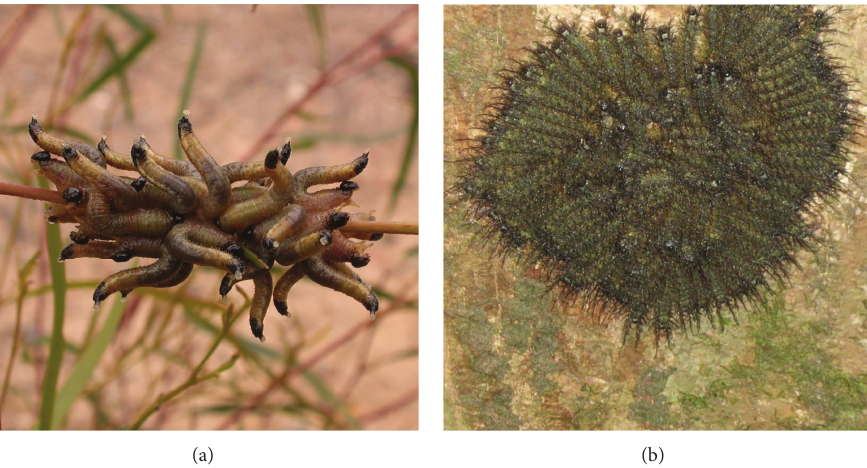
Figure 3: (a) Larvae of Perga sp. (Pergidae) rest aggregated in a cycloalexic formation. Even around a stem of their host plant, Eucalyptus sp., spitfire larvae rest with their heads outwards, Black Mountain, Canberra, ACT, Australia. Photograph by Donald Hobern on 24 May 2010 (CC BY 2.0). (b) Probable cycloalexy with heads pointing outwards in caterpillars of Lonomia sp. (Saturniidae: Hemileucinae) on tree trunk in Peru. Photograph taken near Pongo de Caynarachi, Lamas, San Martin, Peru, and reproduced with the author’s permission © Marc D´ıaz Rengifo (Universidad Nacional Federico Villarreal, Lima, Per´u).